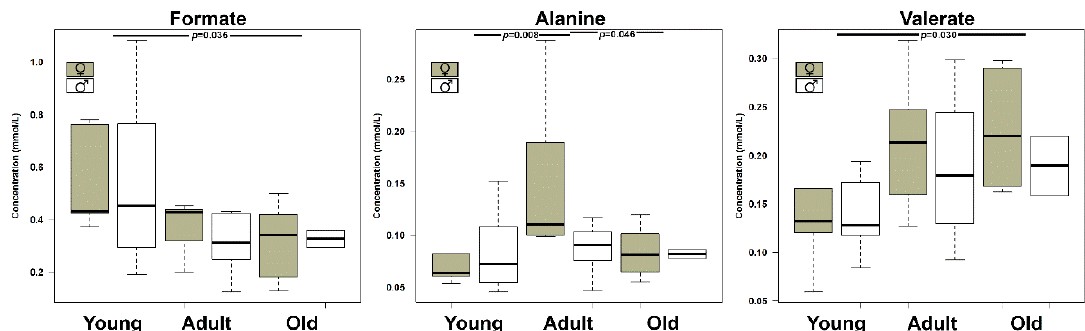
Figure 4. Boxplots showing the concentration of molecules significantly ( p < 0.05) affected by age, as assessed by two-way ANOVA followed by Tukey post-hoc test.